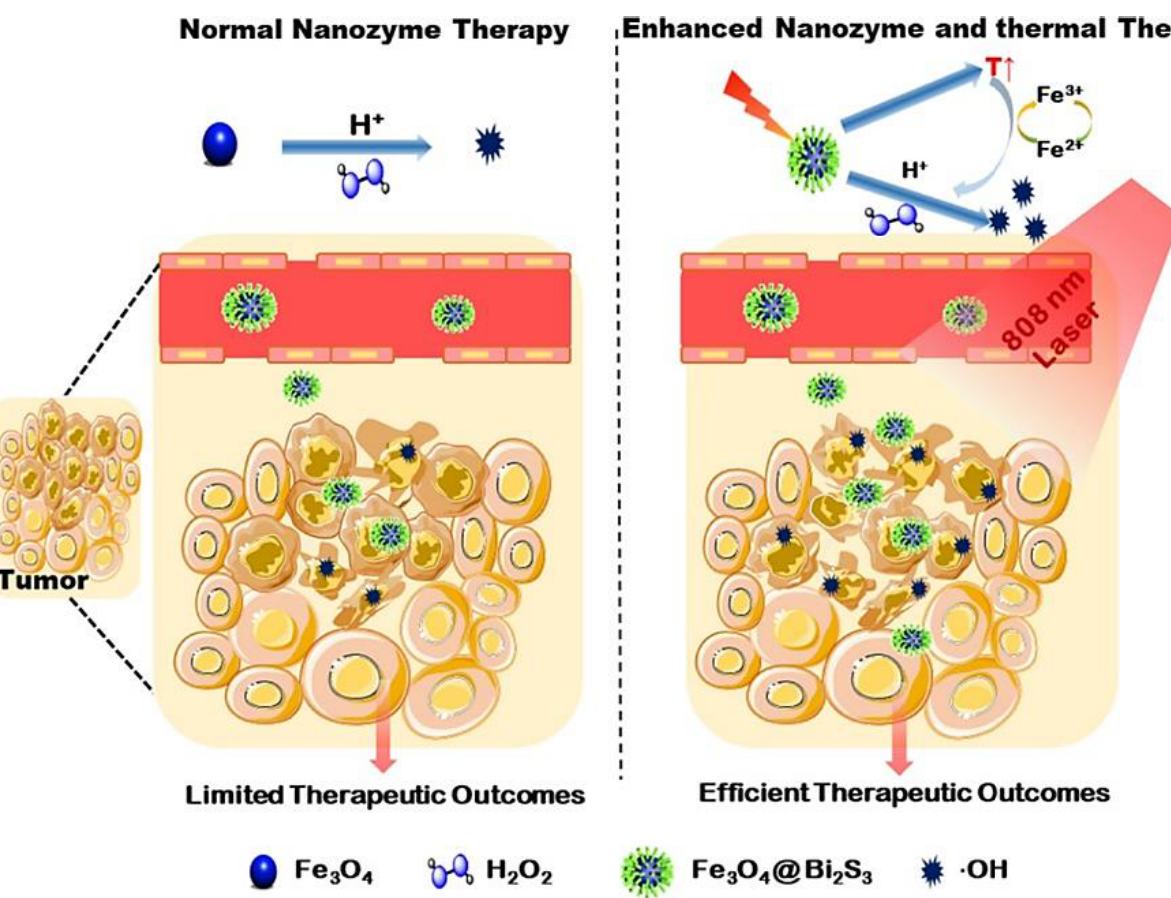
Figure 6. Schematic representation of photothermal-enhanced nanozymatic mediated cancer therapy on viruslike Fe 3 O 4 @Bi 2 S 3 nanozymes. Image was reproduced with permission from reference [101] .